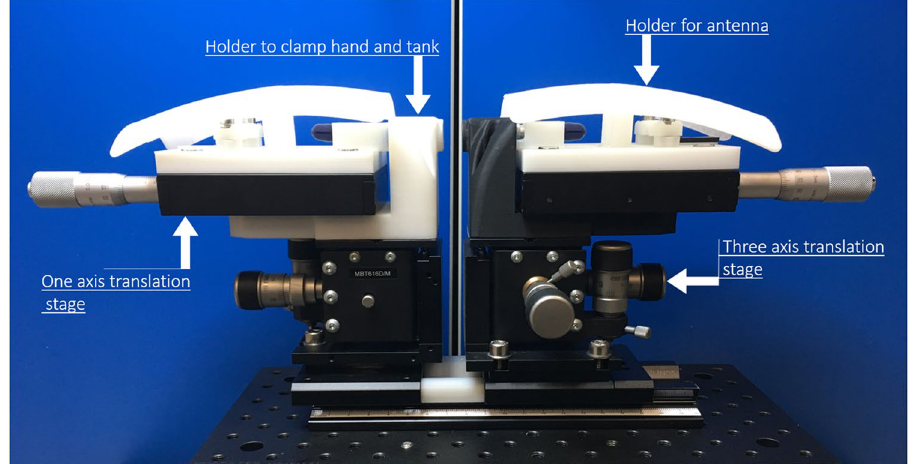
Figure 8. The mechanical setup. The measurement assembly containing two sets of 3-D printed holder and two sets of micro-positioner. The positioners are attached on a plate (optical table). The whole sensor can be mounted on a three axis rotational arm to align precisely against hand or ear lobe for human trial.